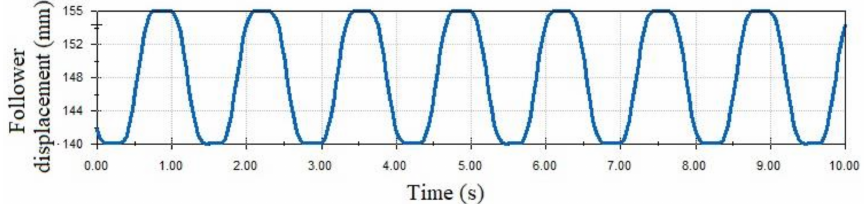
Figure 10. Follower displacement function, for several operating cycles, obtained with the motion module of